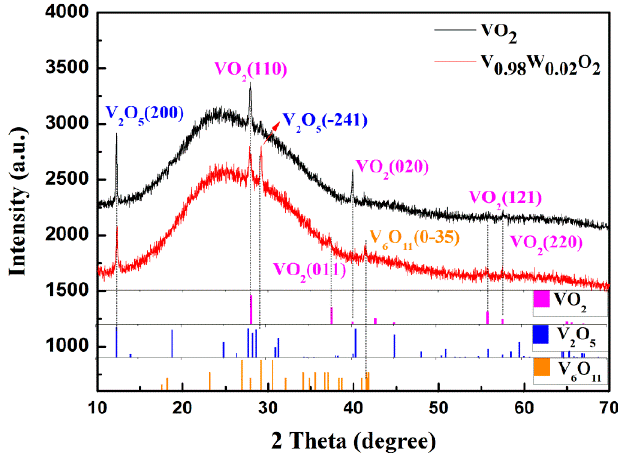
Figure 2. SEM surface micrographs of pure and 2% W-doped V films before and after annealing. ( a ) Pure V film before annealing. ( b ) 2% W-doped V film before annealing. ( c ) Pure V film after annealing. ( d ) 2% W-doped V film after annealing. The films were sputtered with the power of 500 W: 0 W and 0 W: 500 W for the pure and 2% W-doped V targets without heating, respectively. They were annealed at 530 °C for 30 min with oxygen pressure of 18 Pa.